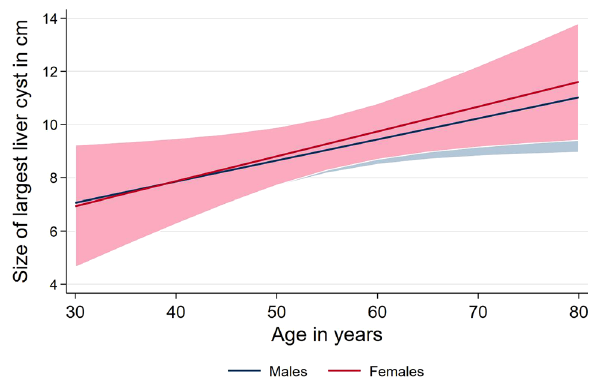
Figure 4. Association between mean size of cysts and age for male and female